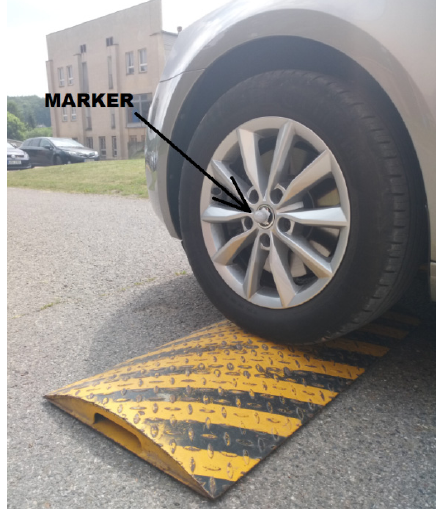
Figure 1. Obstacle on the road.